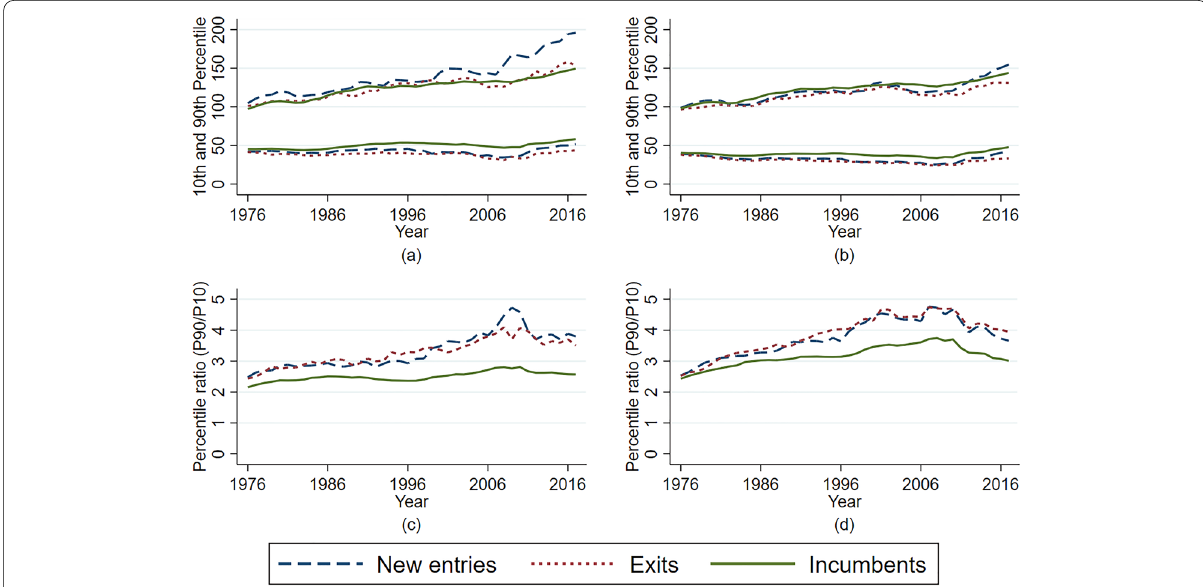
Fig. 13 10th and 90th percentile of the distribution of real average wages. a Depicts the manufacturing sector, b depicts the service sector. c Depicts the percentile ratio for the manufacturing sector, d depicts the percentile ratio for the service sector